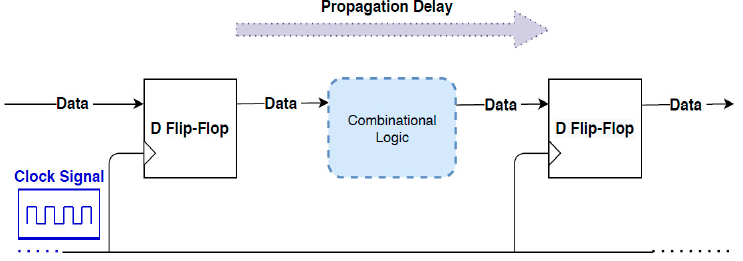
Figure 2. Synchronous representation of digital ICs .